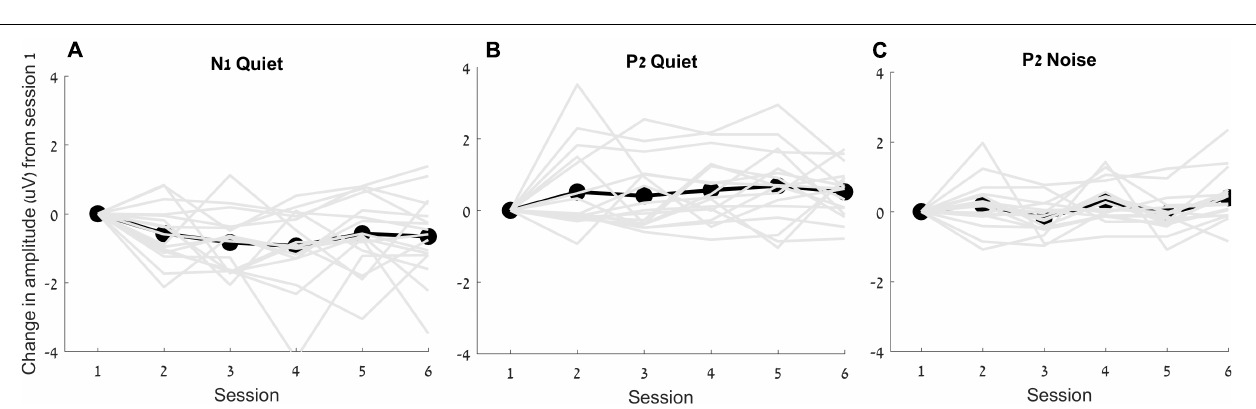
FIGURE 4 | Grand averaged waveforms of the experimental group at the vertex electrode Cz, in quiet (right) and noise (left) conditions over the six sessions.